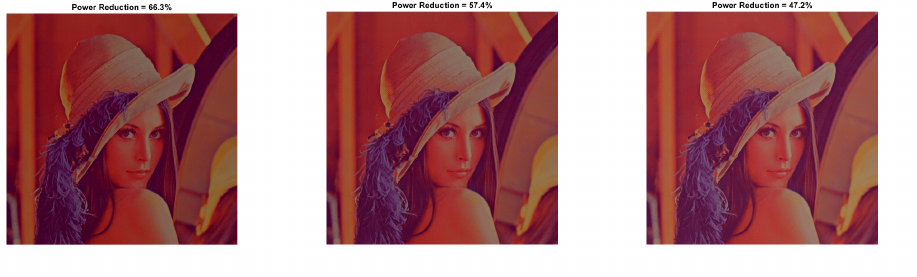
Figure 5. Resulted image I new using Y CBCS (without HE) for a = 0.5 and b =